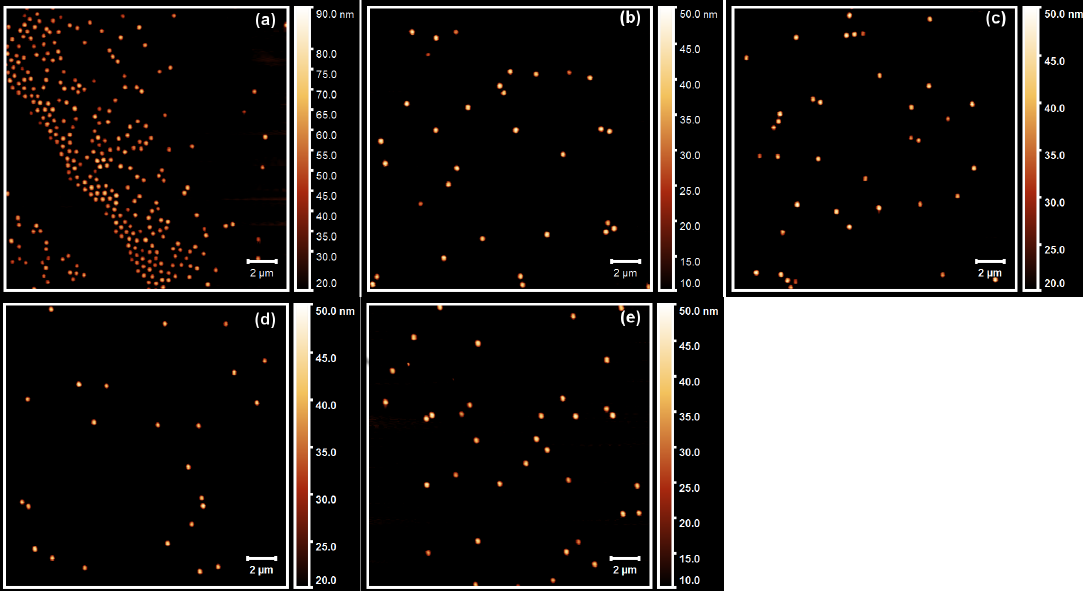
Figure 2. AFM images of all core-shell microgels with a PNIPAM- co -AAc core and a shell composed of ( a ) PNN100/PMAM0; ( b ) PNN75/PMAM25; ( c ) PNN50/PMAM50; ( d ) PNN25/PMAM75 and ( e ) PNN0/PMAM100.